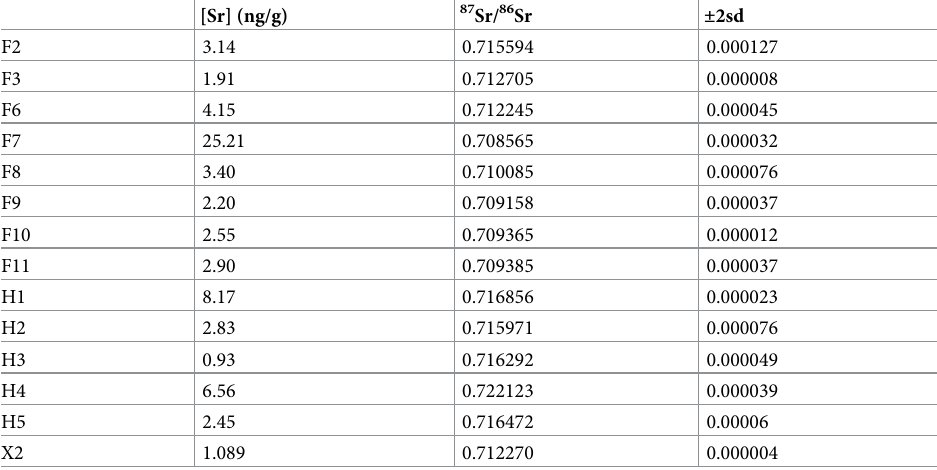
Table 7. Sr isotopic composition of timbers from 3 buildings in